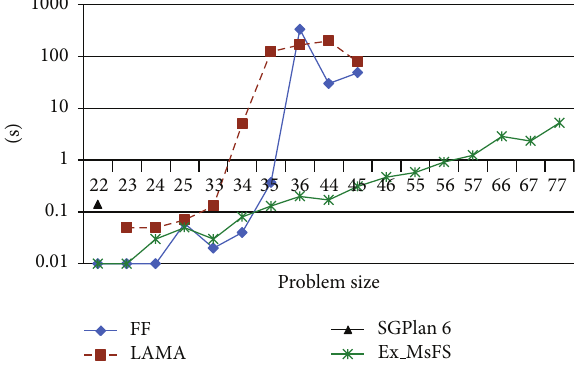
Figure 7: Planning results of air defense of naval group